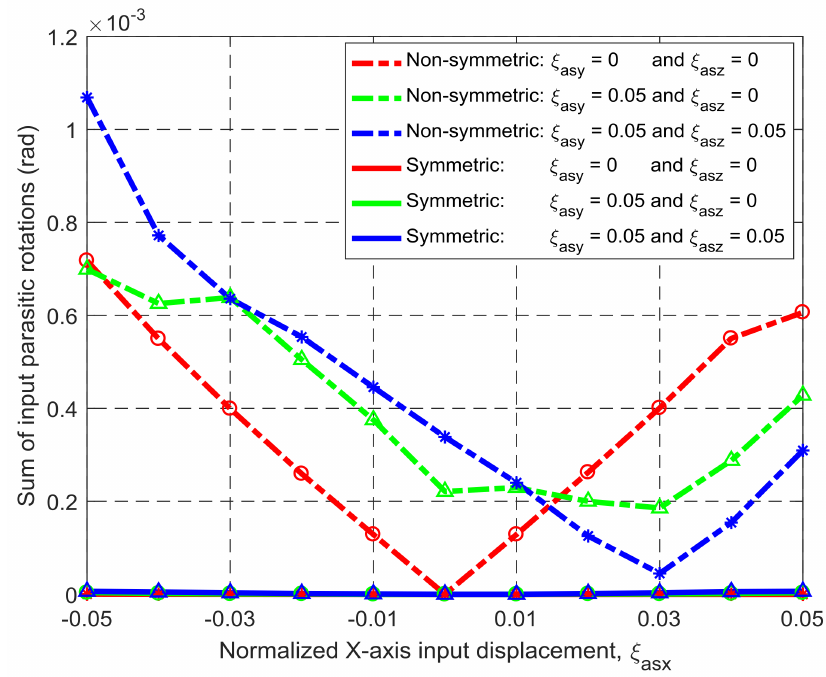
Figure 10. Comparison of input parasitic rotations between the symmetric and non-symmetric XYZ CPMs shown in Figure 3a,h (Symbols, ‘*’, ‘ (cid:52) ’ and ‘